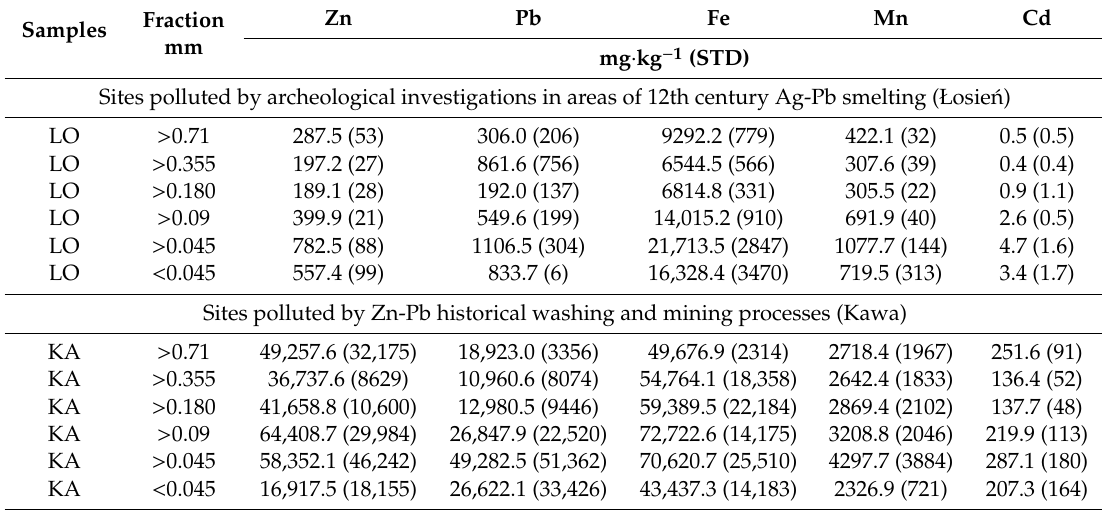
Table 4. Metals concentration in topsoil fraction from historical smelting (Łosie´n—LO) and processing operation (Kawa—KA). Five samples were collected in each location (see: